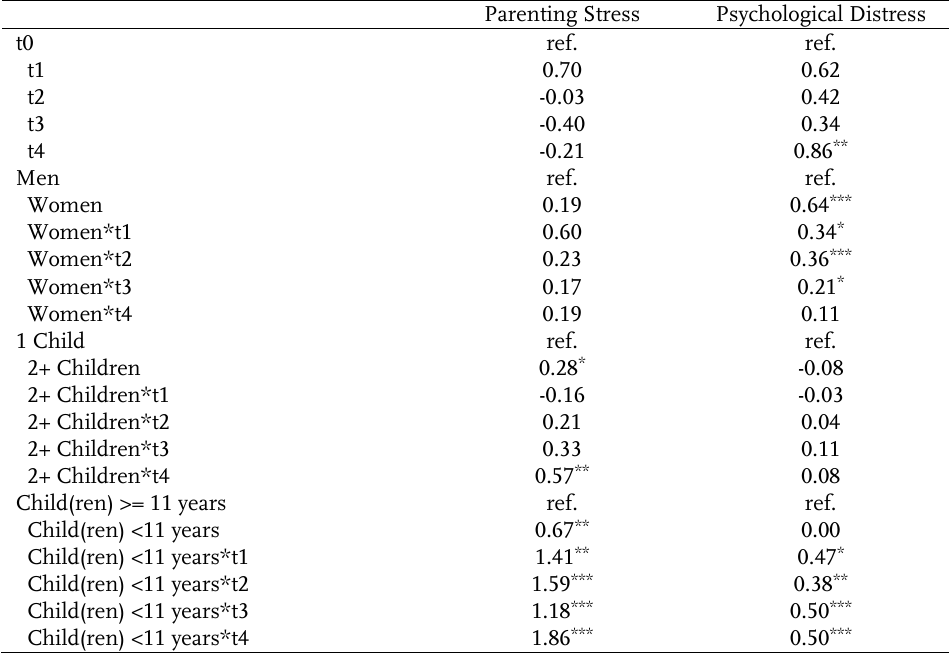
Table A.2 : OLS Regressions on Parenting Stress and Psychological Distress Parenting Stress Psychological Distress ref.